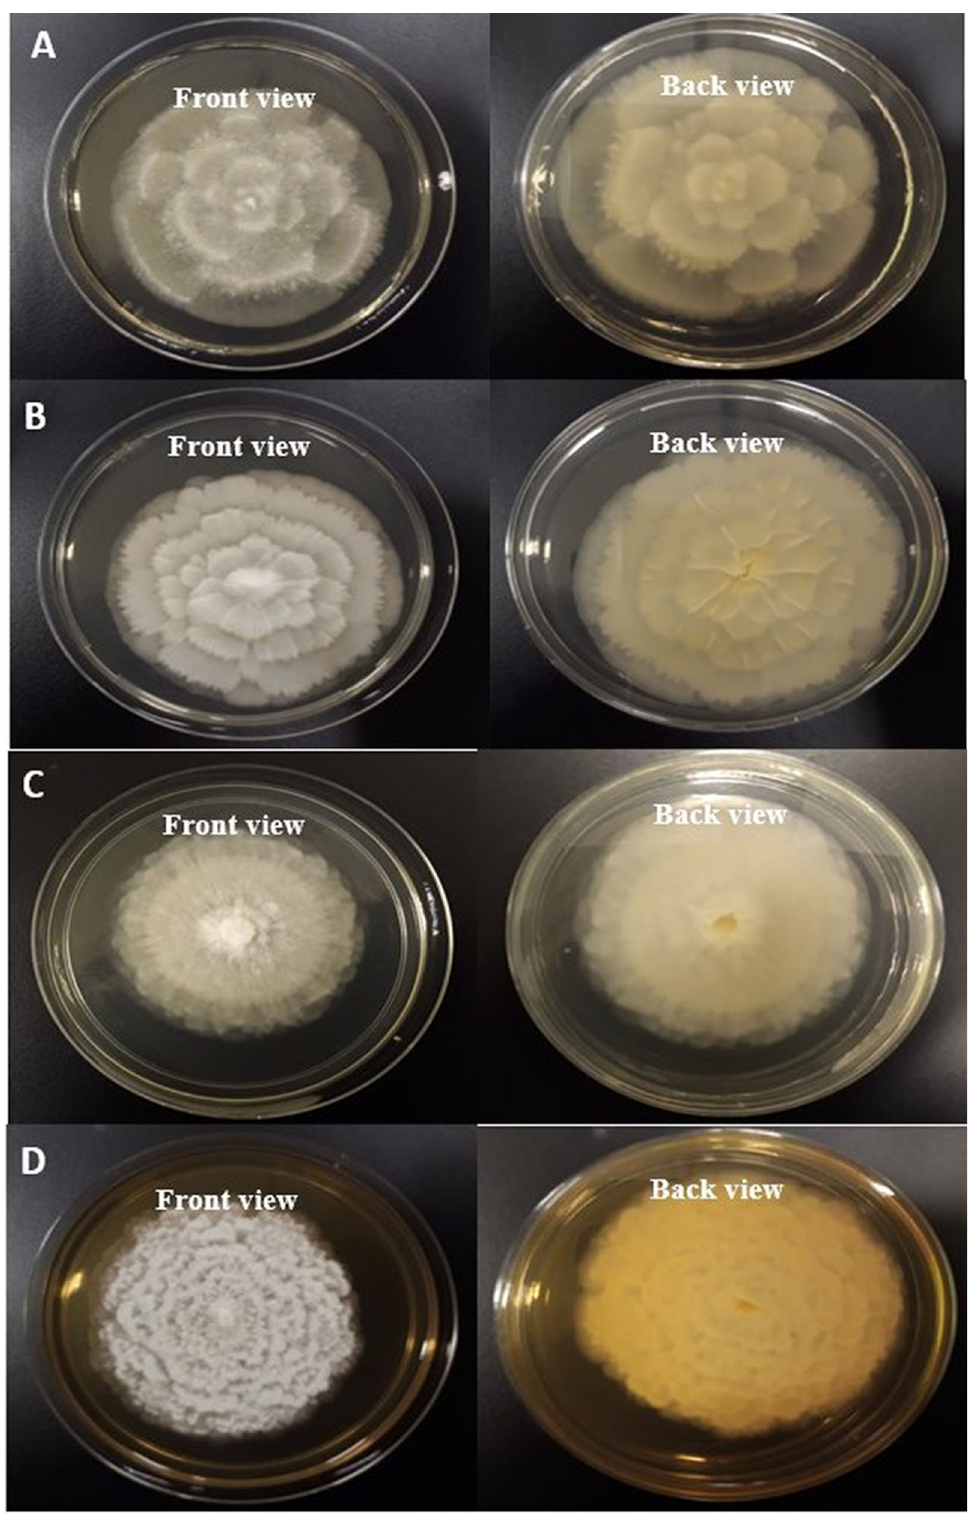
Figure 1. Colonies of fungal isolates on potato dextrose agar (PDA) medium (front view and back view) after 7 days of incubation at 25 ° C. (A) MSU-101 colonies on PDA front and back view. (B) MSU-201 colonies on PDA front and back view. (C) MSU-401 colonies on PDA front and back view. (D) MSU-501 colonies on PDA front and back